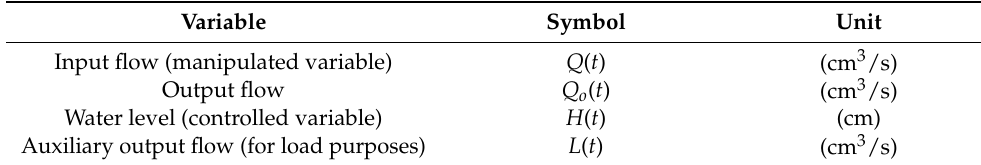
Table 2. Tank model variables.